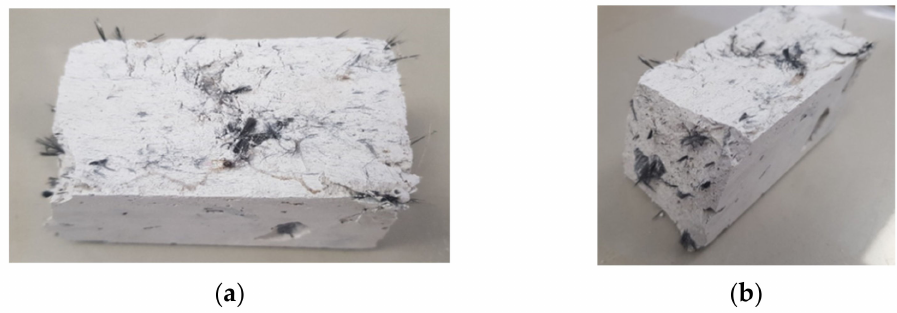
Figure 2. Results of the bending test, plan view ( a ); perspective view ( b ). (Source: the author.)